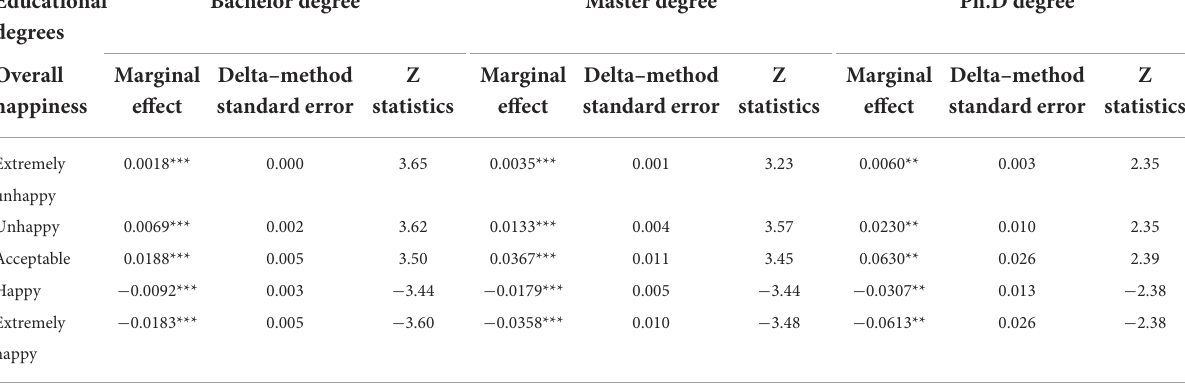
TABLE 15 Marginal effect of different degrees on happiness status.